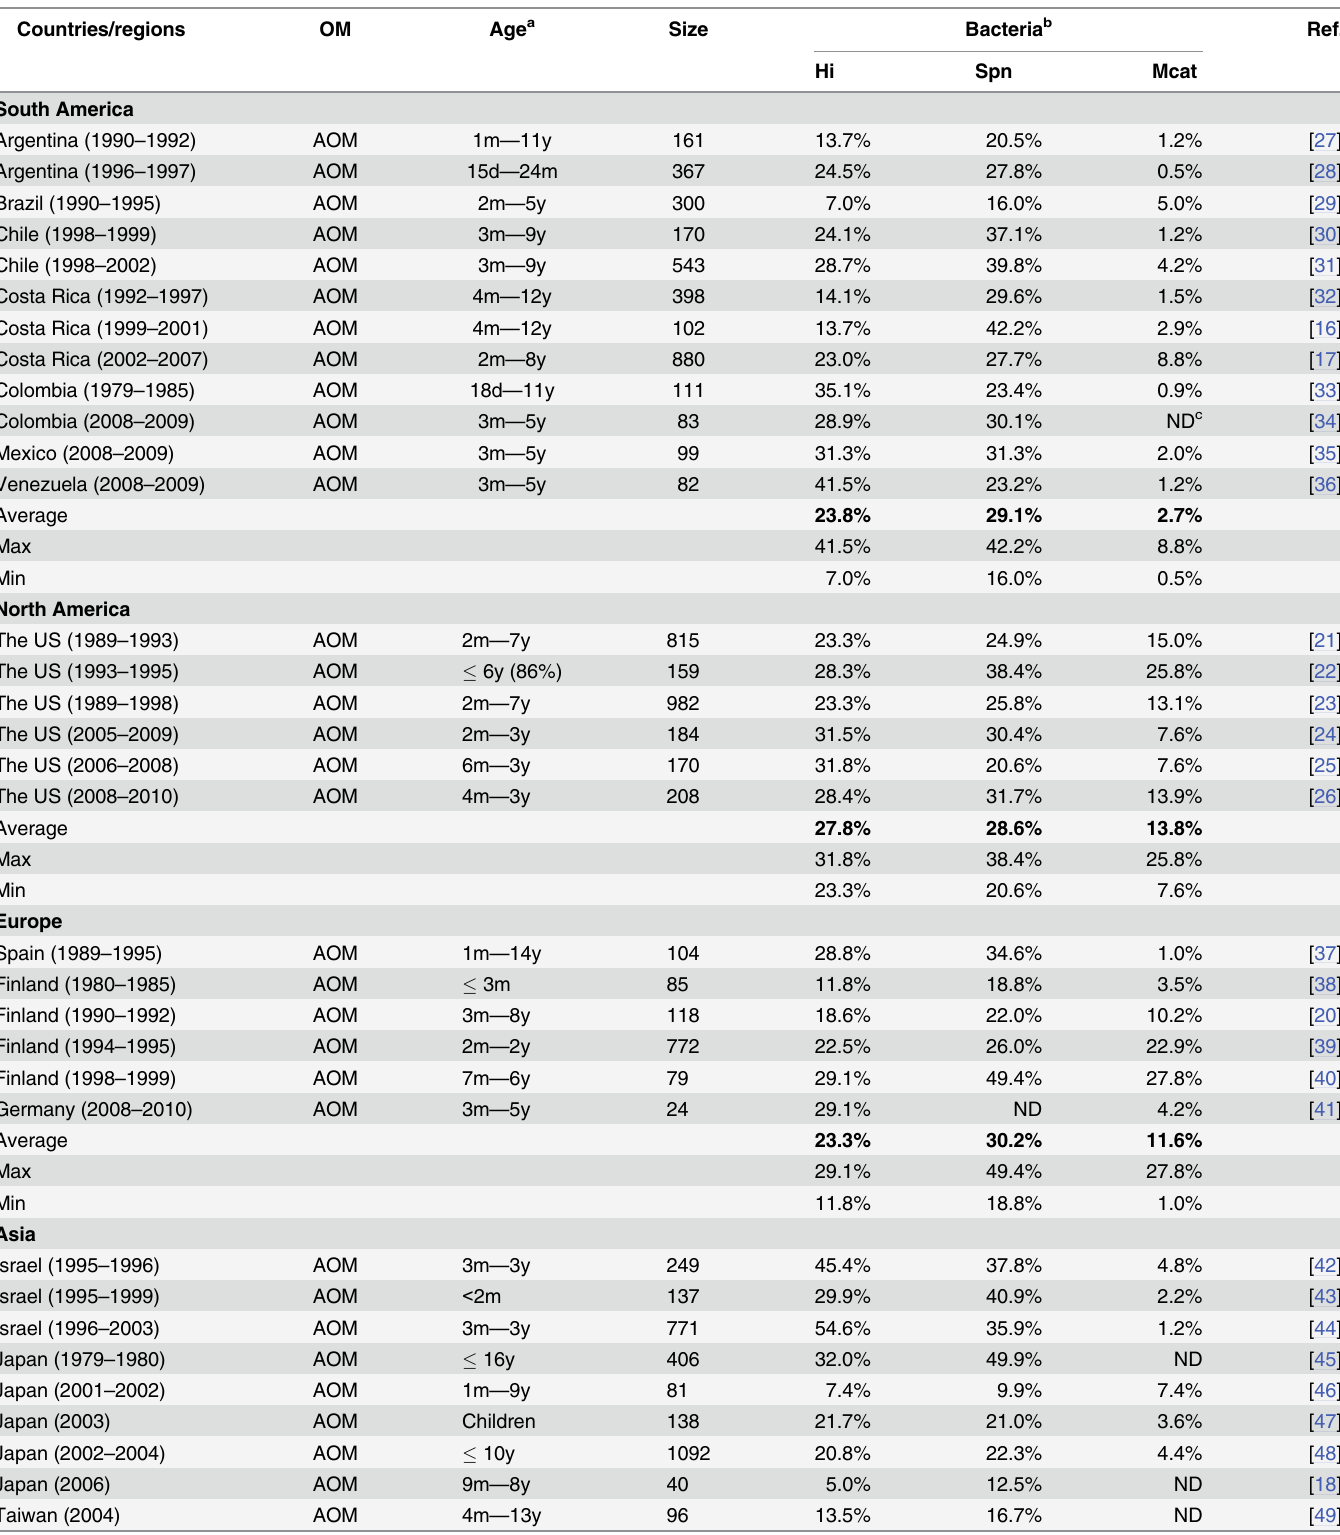
Table 1. S . pneumoniae , H . influenzae and M . catarrhalis detected from MEF of patients with AOM.